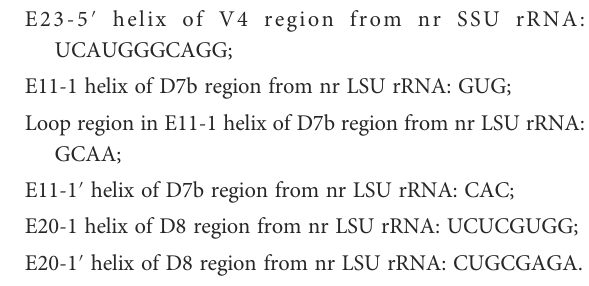
HOLOTYPE: NNIBRPR 25448, a permanent microscope slide